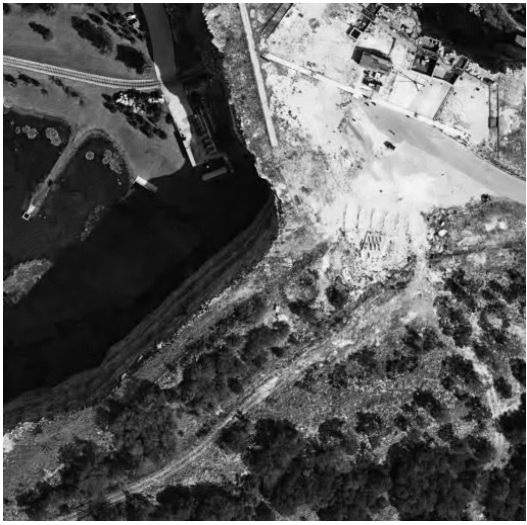
Figure 8. Filtered noisy image by 3D-DCT ( β = 3.0) with reference transformed by the first order polynomial (PSNR out = 34.73 dB; PHVSM out = 38.05 dB).